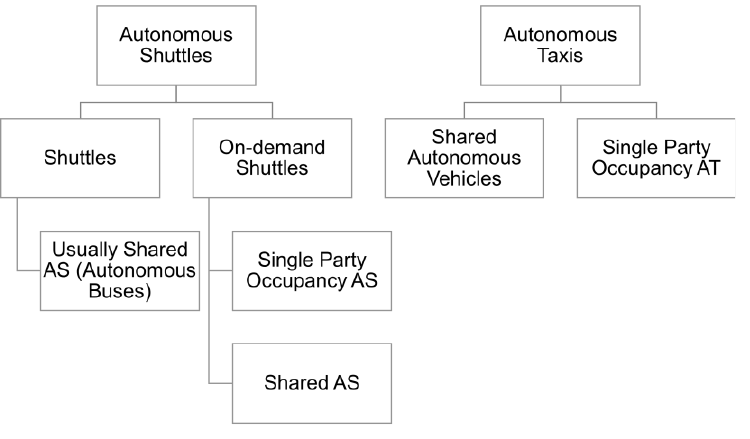
Figure 6. Variations in ATs.